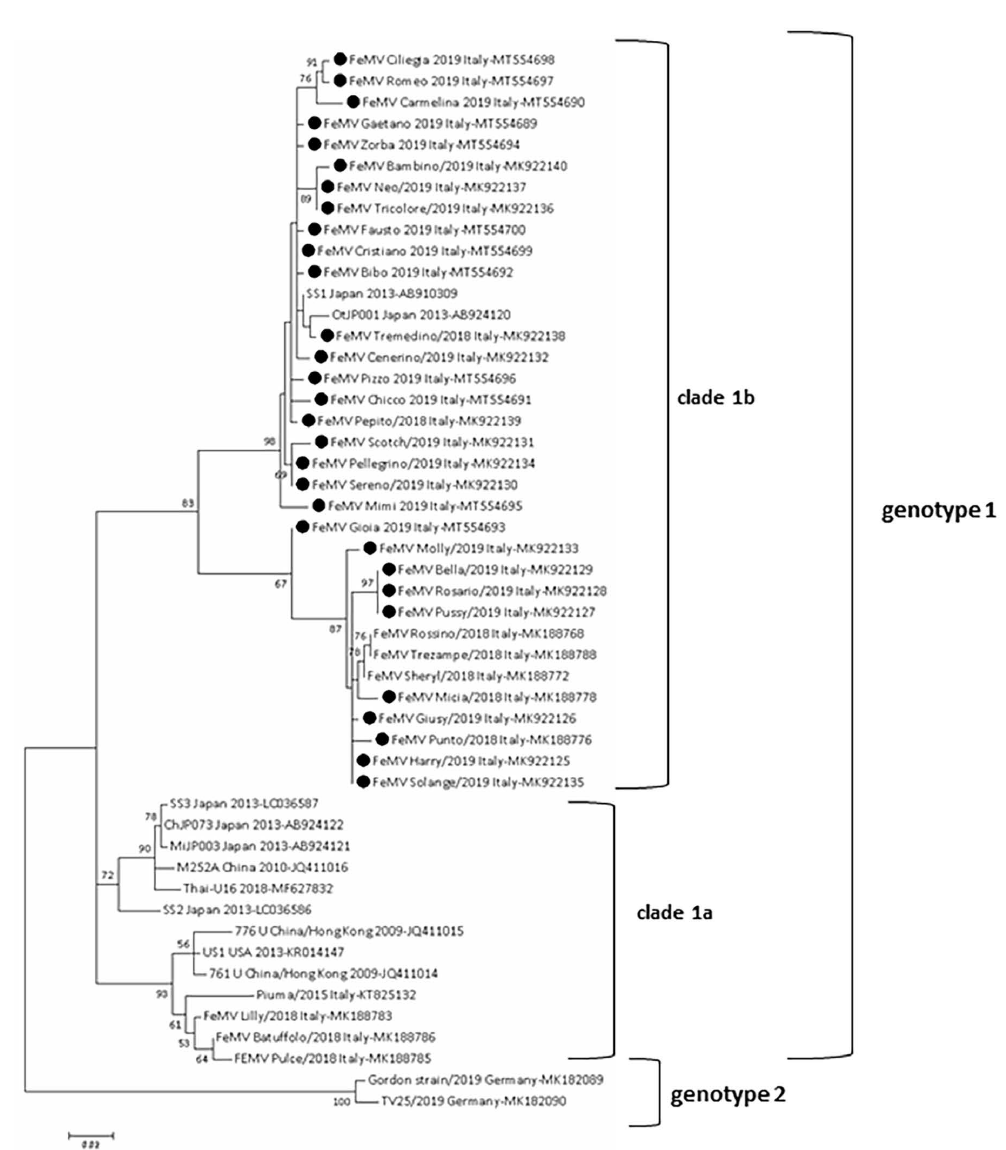
Figure 2. Phylogenetic analysis based on a 400-bp L gene nucleotide sequences of 27 FeMV strains of this study and FeMV sequences publicly available. The analysis involved a total number of 50 nucleotide sequences. The tree with the highest log likelihood ( − 1706.64) is shown. The percentage of trees in which the associated taxa clustered together is shown next to the branches. Initial tree(s) for the heuristic search were obtained automatically by applying Neighbor-Join and BioNJ algorithms to a matrix of pairwise distances estimated using the Maximum Composite Likelihood (MCL) approach, and then selecting the topology with superior log likelihood value. A discrete Gamma distribution was used to model evolutionary rate differences among sites (5 categories (+G, parameter = 0.3706). The tree is drawn to scale, with branch lengths measured in the number of substitutions per site. There was a total of 370 positions in the final dataset. Evolutionary analyses were conducted in MEGA7. Black circle: FeMV sequences obtained in this